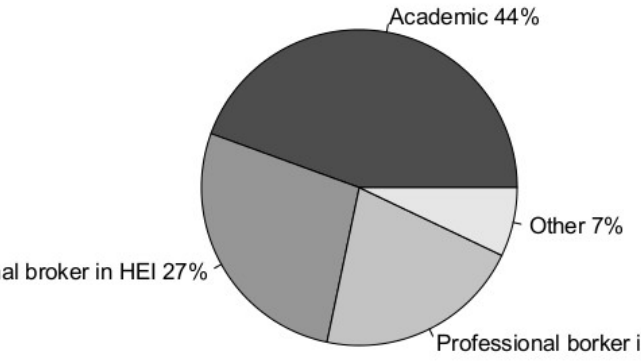
Figure 6. Brokers of museum university partnerships as shown by survey